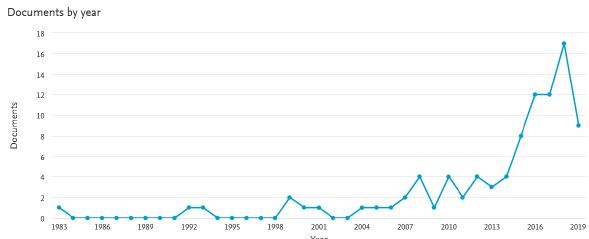
Figure 3. Results of query: TITLE(" benchmark *") and TITLE- ABS-KEY(" photogrammetr y" or " remote sensing ") in Scopus database.